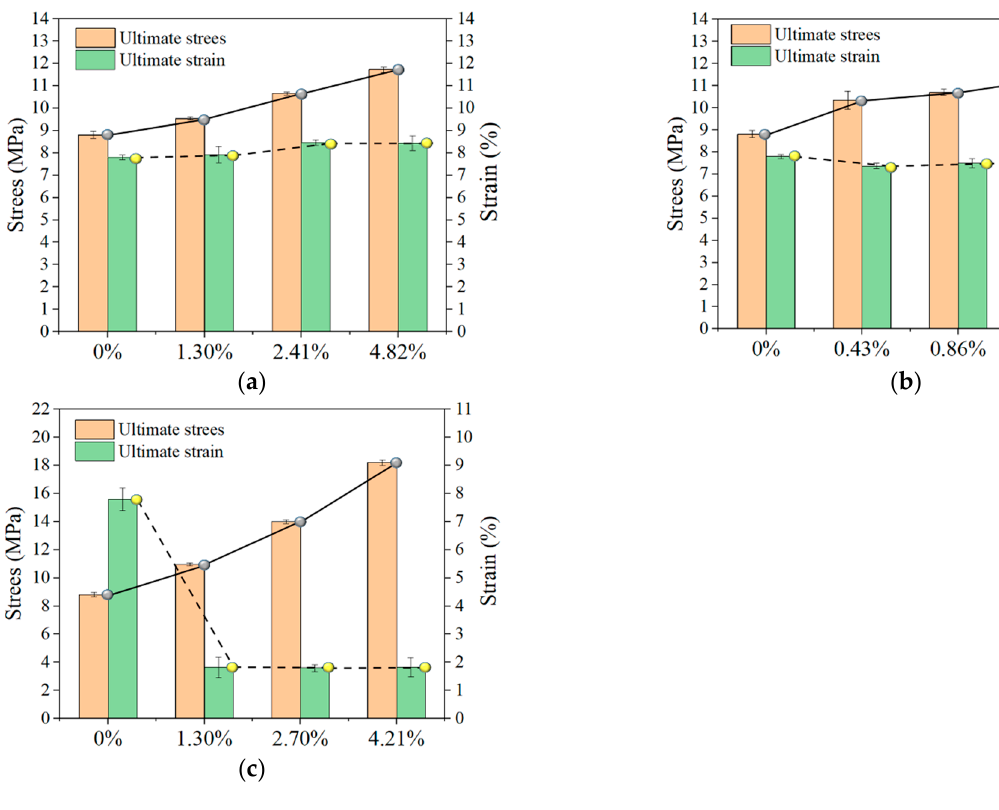
Figure 12. Comparison of ultimate stress and ultimate strain for different enhancement rates: ( a ) PP textile, ( b ) BFRP textile, and ( c ) BFRP grid.